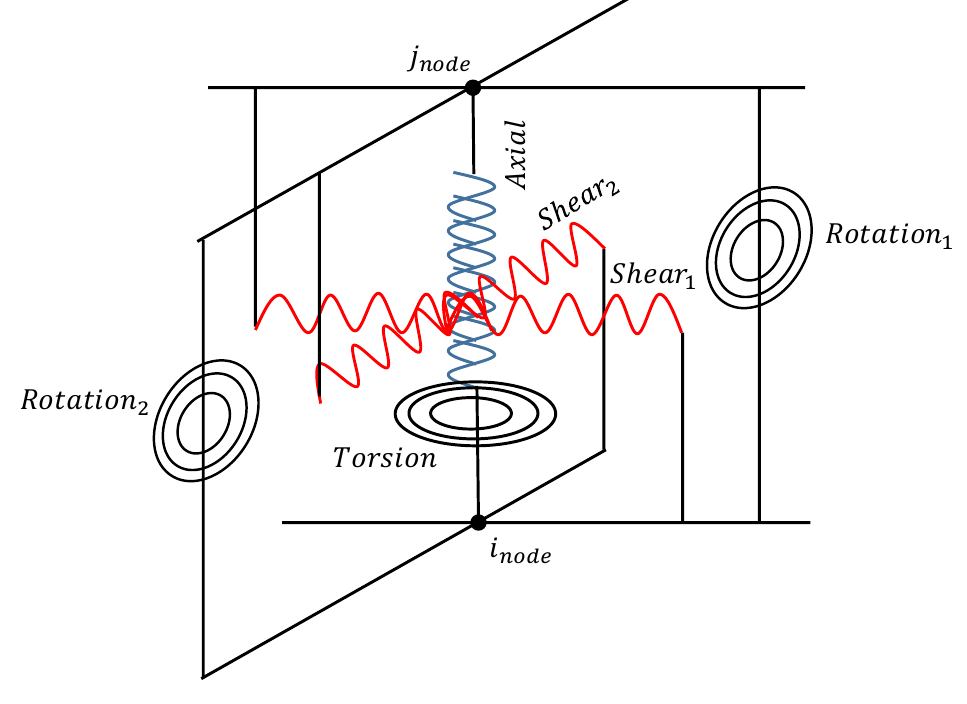
Figure 4. Model representation of the of the HDR Element. Table 2. Defining parameters of the HDR